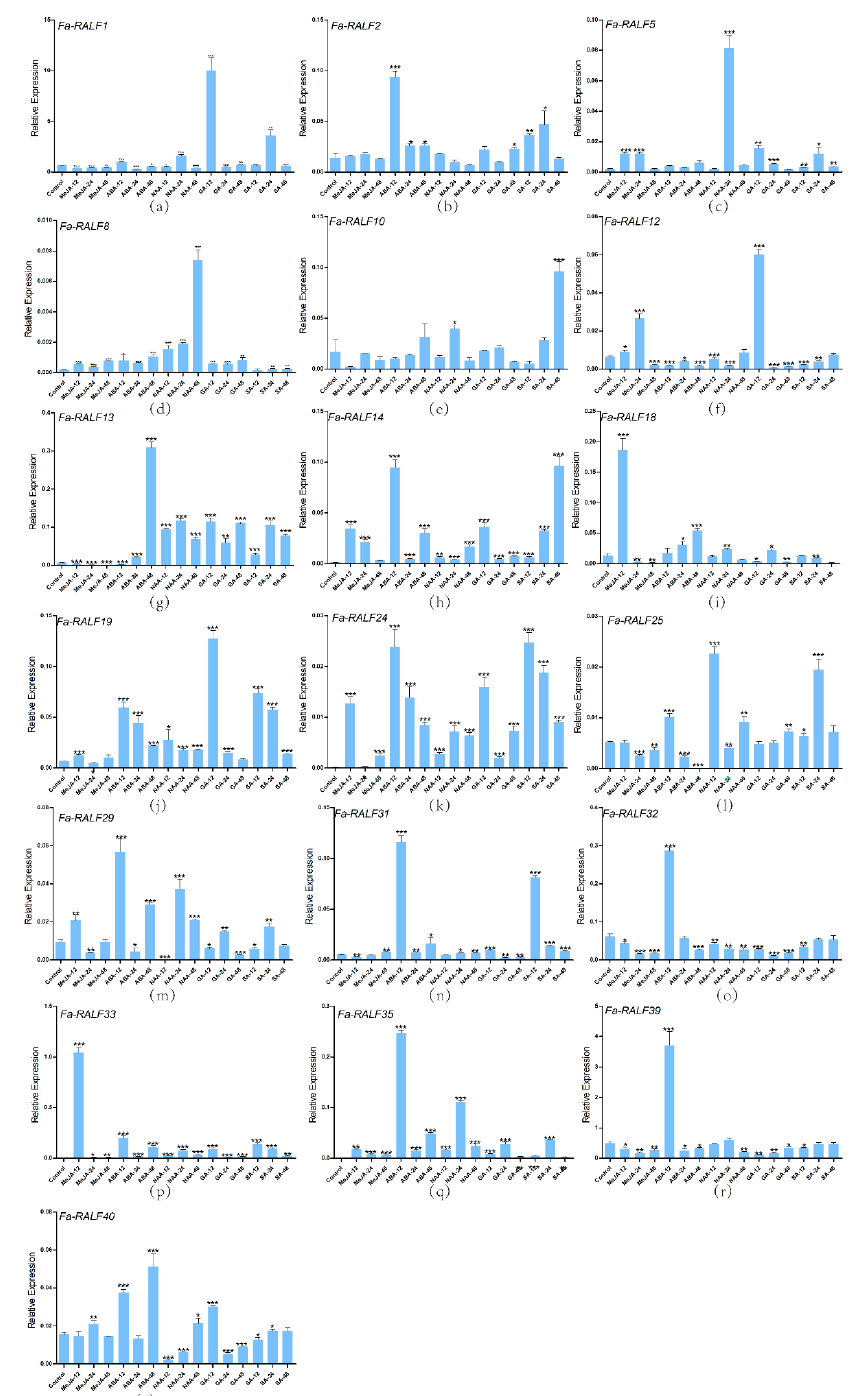
Figure 6. Relative expression profiles of 19 RALF-like genes from Fragaria × ananassa under di ff erent hormone treatments ( a – s ). Error bars represent standard deviation (SD). Columns with stars marked the significantly di ff erent. The numbers of stars stand for the di ff erence extent. The more stars, the higher the significant di ff erence; three stars represents an extreme di ff erence. Here, all the treatments are compared with “control”, and * represents p ≤ 0.05, ** represents p ≤ 0.01, *** represents p ≤ 0.001. MeJA-12,-24,-48: the leaves treated by MeJA after 12, 24, and 48 h; ABA-12,-24,-48: the leaves treated by ABA after 12, 24, and 48 h; NAA-12,-24,-48: the leaves treated by NAA after 12, 24, and 48 h; GA-12,-24,-48: the leaves treated by GA after 12, 24, and 48 h; SA-12,-24,-48: the leaves treated by SA after 12, 24, and 48